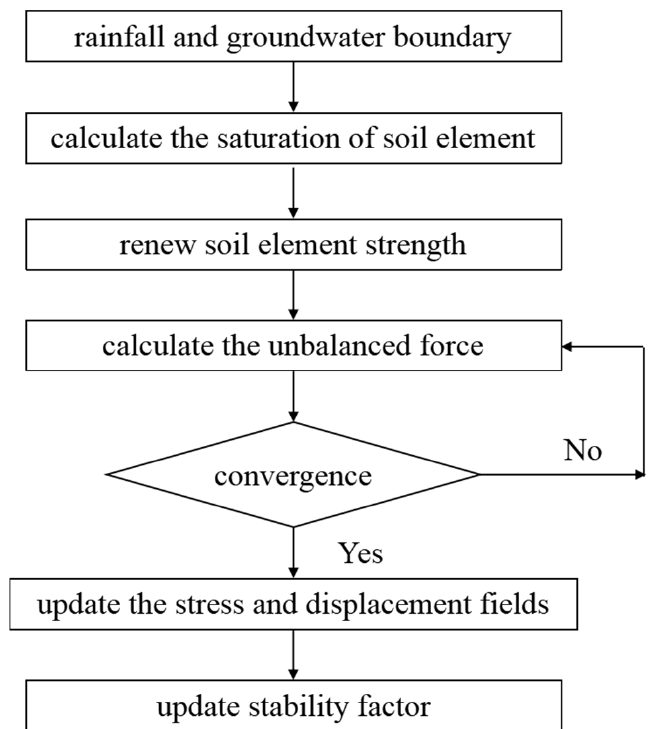
Figure 3. Calculation flow chart.